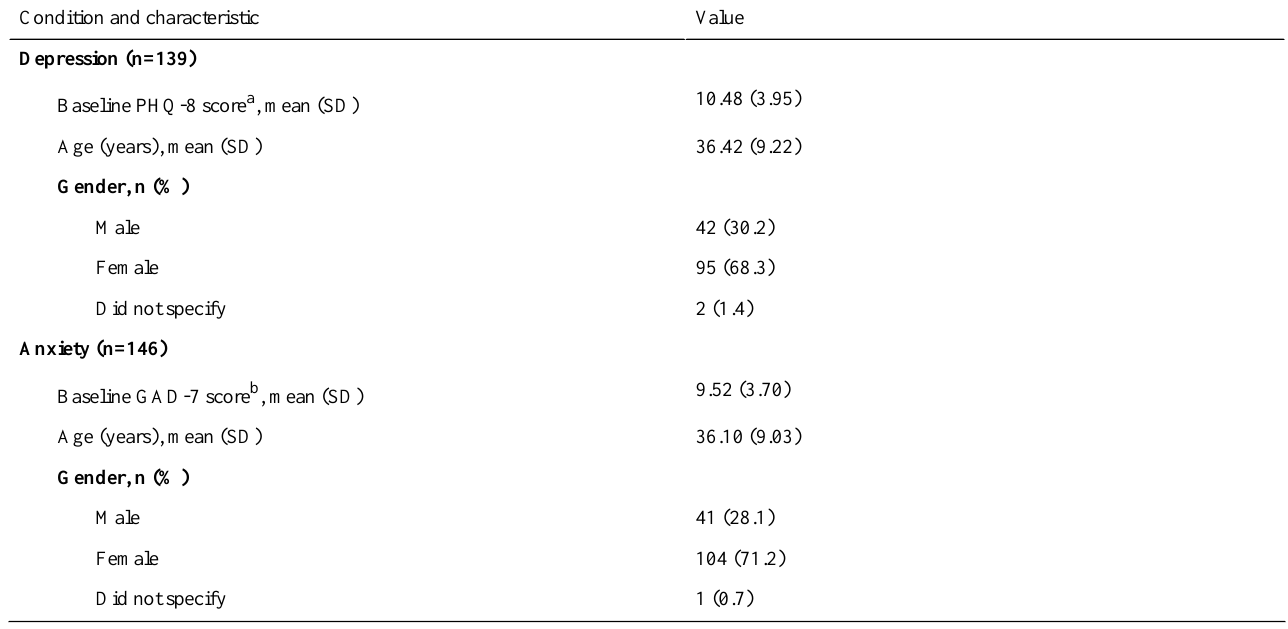
Table 1. Baseline characteristics by